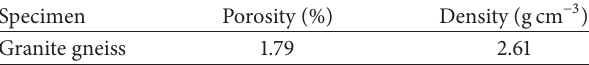
Table 1: Mean value of porosity and density.